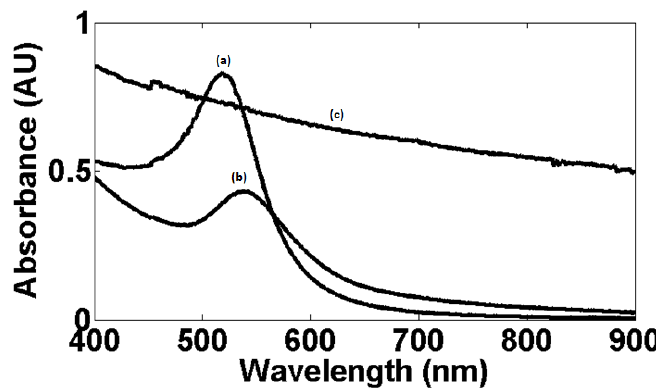
Figure 3. UV–vis spectra of ( a ) GNP ( b ) GNP conjugated wsMWCNTs and ( c ) wsMWCNTs.